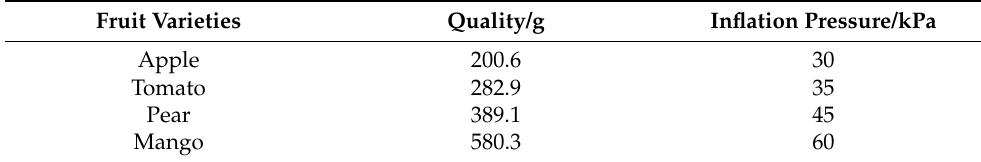
Table 4. The weight of the object to be grasped and the driving air pressure. Fruit